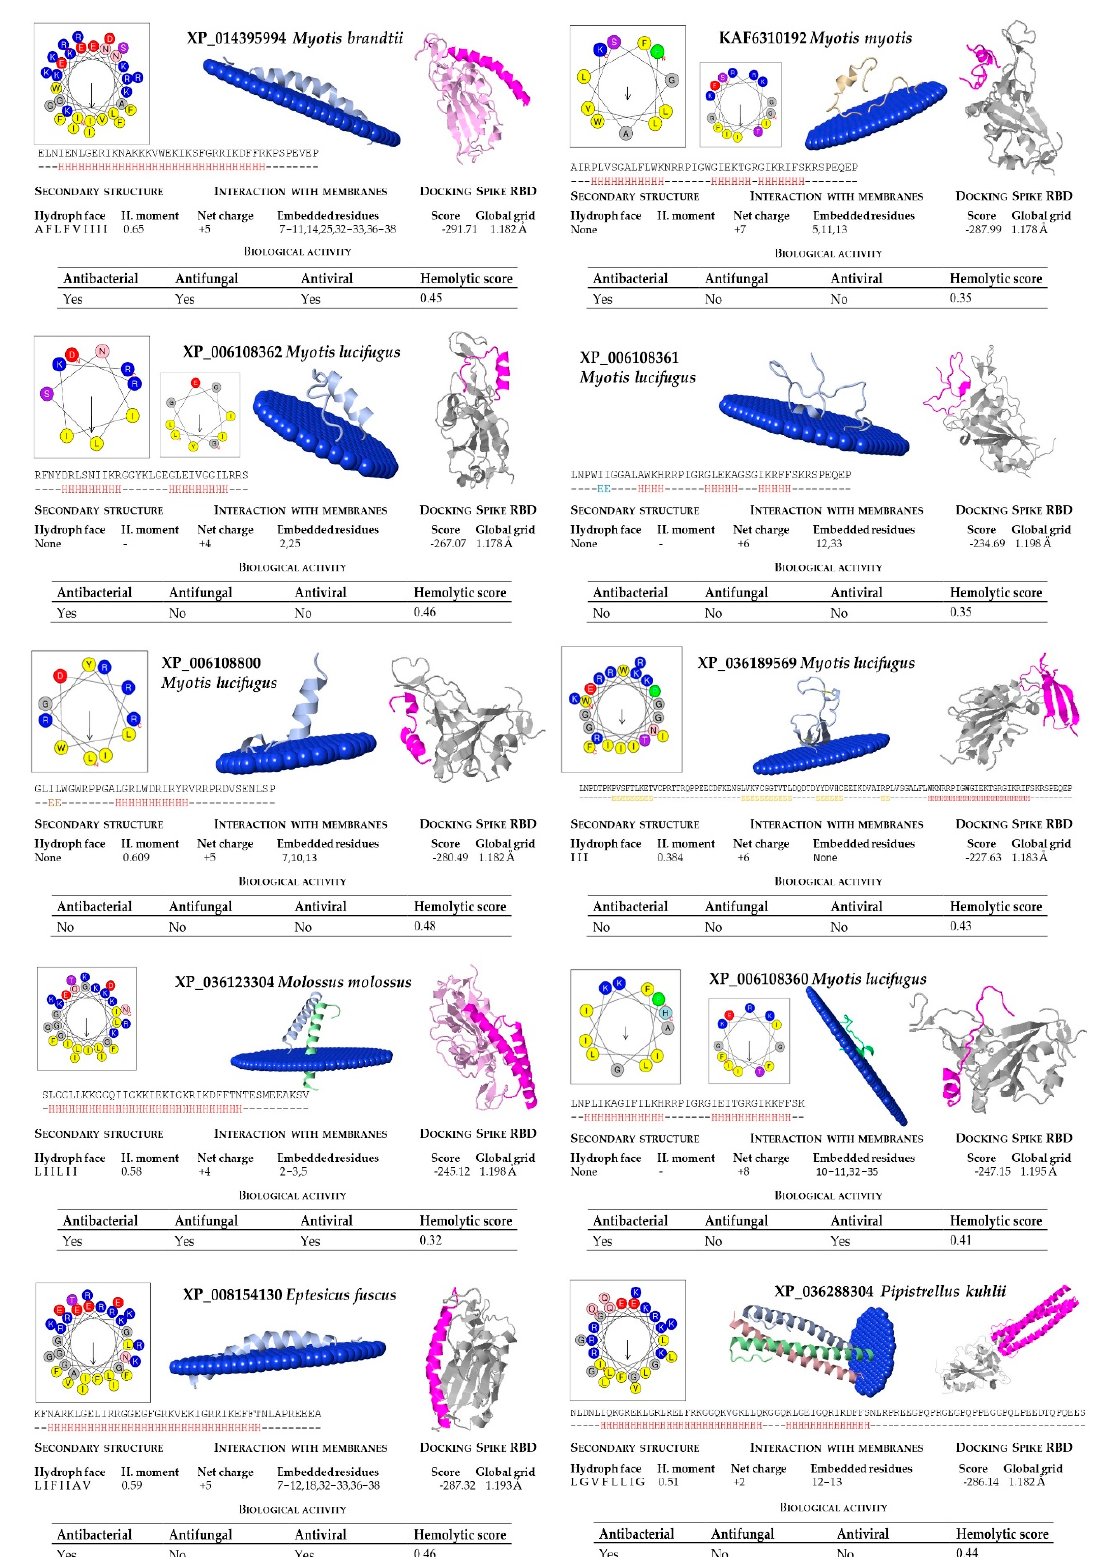
Figure 5. Bioinformatic analysis of bat cathelicidins (part 2). Net charge, secondary structure, hydrophobicity of helixes, interaction with membranes and with the SARS-CoV-2 region binding domain (RBD) of the Spike protein were computed. The analysis included predictions of biological properties of the peptides, such as antibacterial, antifungal, antiviral, and hemolytic